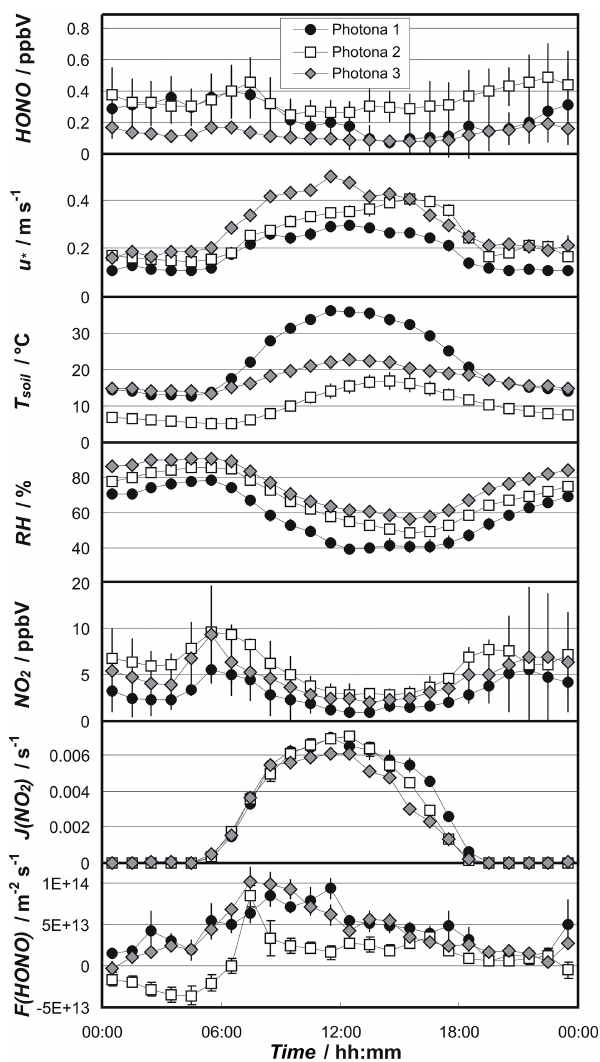
Figure 4. Diurnal average data of the HONO flux, F (HONO), and its potential precursors and driving factors HONO, u ∗ , T soil , c (NO 2 ) and J (NO 2 ) during the three PHOTONA